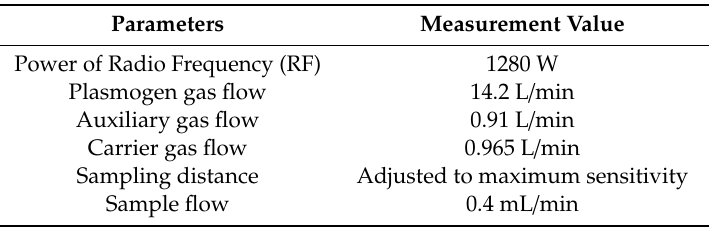
Table 3. Instrumental parameters used in the double-focus inductively coupled mass spectrometry (ICP-MS): plasma and sample introduction